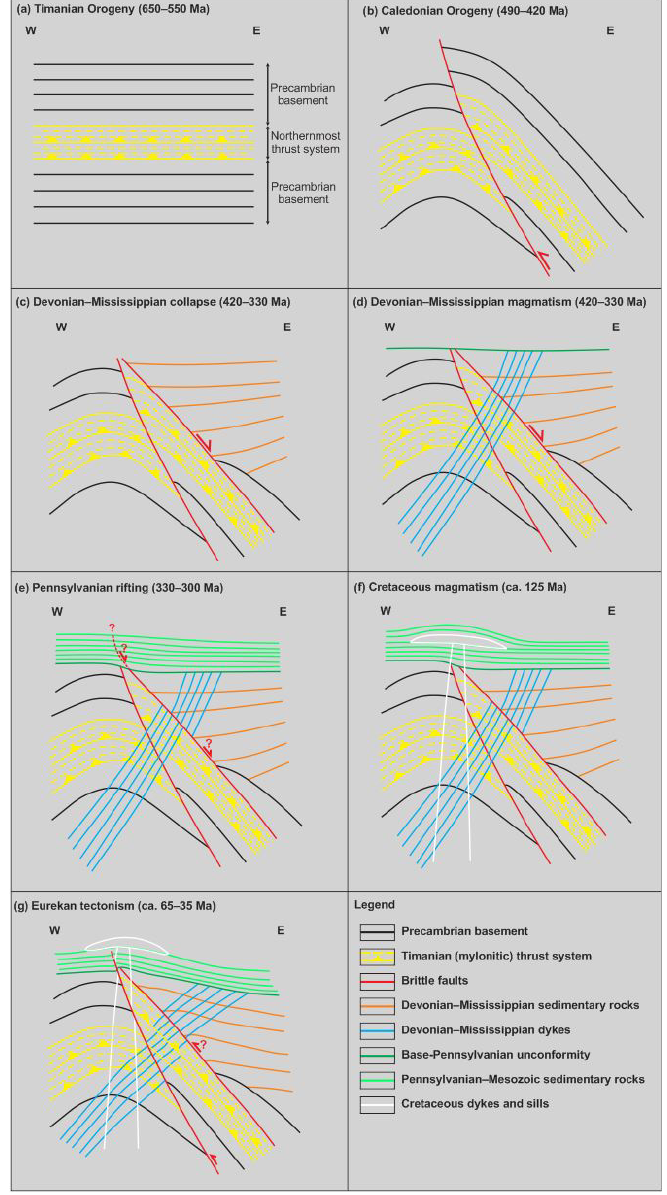
Figure 6. Sketches showing a possible reconstruction of the tectonic history of the E–W seismic profile in Nordmannsfonna shown in Fig. 3e. (a) Formation of a NNE-dipping, mylonitic thrust system (Kongsfjorden–Cowanodden fault zone) within Precambrian basement rocks dur- ing the Timanian Orogeny in the latest Neoproterozoic. The NNE-dipping Kongsfjorden–Cowanodden fault zone appears nearly horizontal on the E–W transect. (b) Top-west thrusting along the east-dipping Agardhbukta Fault and folding of the Kongsfjorden–Cowanodden fault zone into a broad, moderately NNE-plunging anticline during the Caledonian Orogeny. (c) Inversion of the Kongsfjorden–Cowanodden fault zone along the eastern flank of the Caledonian anticline and deposition of thickened, gently west-dipping, syn-tectonic, Devonian (–Mississippian?) sedimentary strata during post-Caledonian collapse-related extension. (d) Intrusion of Precambrian basement and Devo- nian (–Mississippian?) sedimentary rocks by steeply west-dipping dikes in the Devonian–Mississippian. (e) Regional erosion in the mid- Carboniferous (latest Mississippian) and deposition of Pennsylvanian sedimentary strata, possibly along a high-angle brittle splay of the inverted portion of the Kongsfjorden–Cowanodden fault zone during rift-related extension. (f) Deposition of Mesozoic sedimentary strata and intrusion of Cretaceous dolerite dikes and sills. (g) Erosion of Pennsylvanian–Mesozoic strata and reactivation of the Kongsfjorden– Cowanodden fault zone and Agardhbukta Fault with minor reverse movements in the early Cenozoic during the Eurekan tectonic event as shown by mild folding and offset of overlying post-Caledonian sedimentary strata, dikes, and base-Pennsylvanian unconformity. Also note the back-tilting (i.e., clockwise rotation) of Devonian–Mississippian dikes in the hanging wall of the Agardhbukta Fault and of the Kongsfjorden–Cowanodden fault zone.